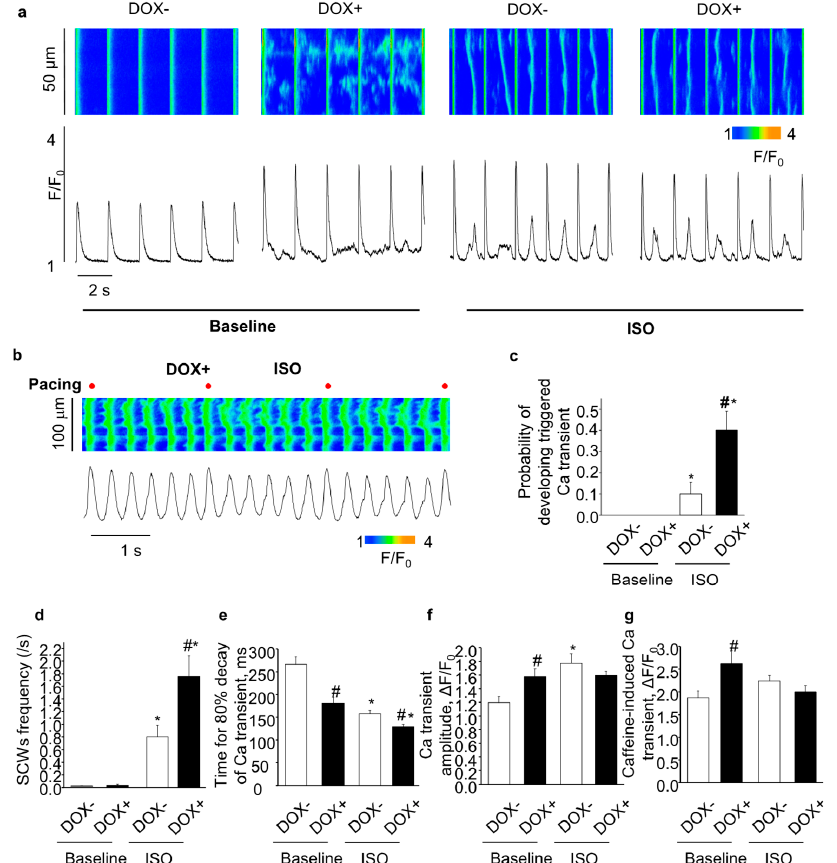
Figure 4. The effect of acute SERCA2a overexpression on Ca handling in intact CASQ2 KO ventricular myocytes paced at 0.5hz. ( a ) representative line-scan images (top) and time-dependent profiles (bottom) of spontaneous Ca waves (SCWs) at baseline and in the presence of 100 nM ISO; ( b ) example of triggered Ca transient in DOX+ ventricular myocytes, in the presence of ISO. Electrical stimulation is indicated by the red dot labeling; ( c ) the probability of the cells developing triggered Ca transient; ( d ) the summary of frequency of SCW; ( e ) the kinetics of 80% Ca transient decay; ( f ) amplitude of Ca transients; ( g ) amplitude of caffeine-induced Ca transients. * p < 0.05 vs baseline, # p < 0.05 vs. DOX − .